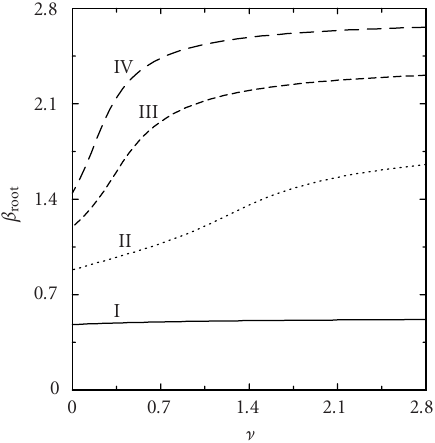
Figure 4.5. The variation of β root as a function of the nonintegrability parameter ν for various values of the parameter a . It is obtained from the exact calculation. For this figure, (cid:7) H 0 = constant, x 0 = 0 . 0, and λ = 1. Curve I: a = 0 . 5, curve II: a = 1 . 0, curve III: a = 1 . 5, and curve IV: a = 2 .